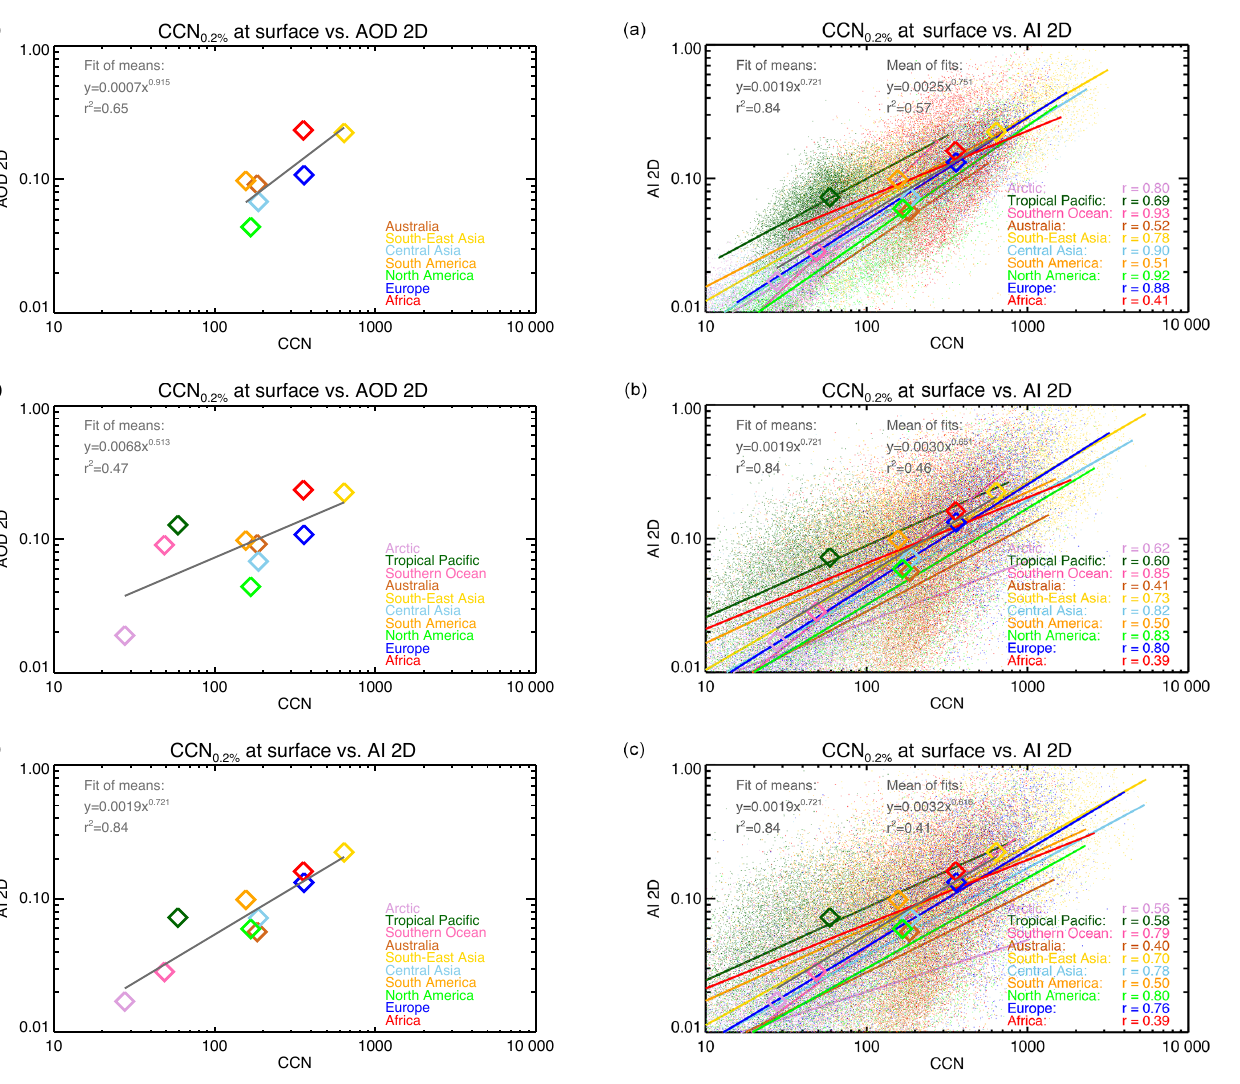
Figure 5. Annual continental mean ECHAM-HAM simulated AI [1] as a function of CCN 0 . 2% [cm − 3 ] (symbols) and their fit derived from linear regression (gray); overlay of (a) monthly mean, (b) daily mean and (c) instantaneous 6 hourly pairs of AI and CCN 0 . 2% (scatter) and their fit derived from linear regression. For visualisation, data in scatterplot randomly sub-sampled to 10000 pairs. Regional colour coding as in Fig.